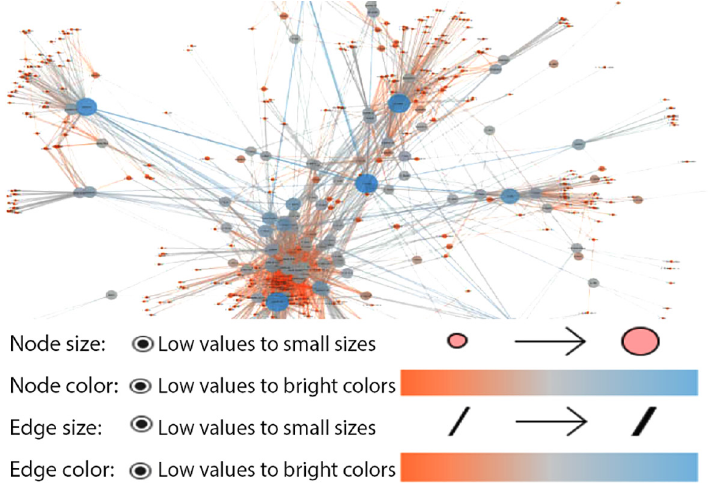
Figure 4. Visual representation of a part of an information network. Cytoscape software version 3.7.2 is used to form this